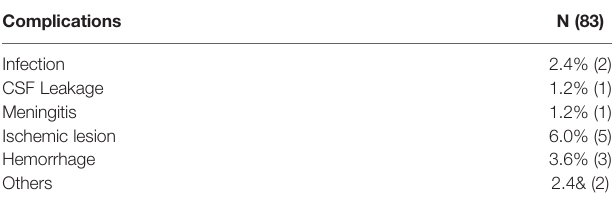
TABLE 2 | Surgical complications (CSF – cerebrospinal fl